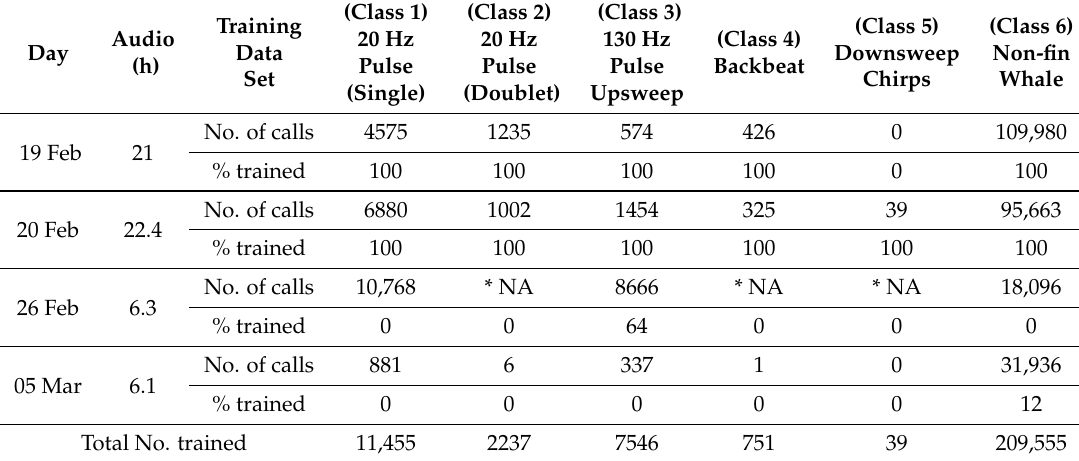
Table 2. Training data set was extracted from a subset of POAWRS detections within the 10–200 Hz frequency range, observed off the coast of Alesund, Norway on 19–20 February 2014; off the coast of Northern Finnmark, Norway on 26 February 2014; and off the coast of Lofoten, Norway on 5 March 2014. Note that the total number of non-fin whale (Class 6) detections is significantly larger when going up to the 4 kHz frequency range since this training set is only a subset of the overall POAWRS detections on each day. (* The number of calls could not be confidently estimated (NA, not accessible) for the 20 Hz pulse (doublet), downsweep chirps, and backbeats measured off the coast of the Northern Finnmark region on 26 February 2014 due to multiple known and unknown marine mammal species vocalizing in close proximity and in the same frequency band).